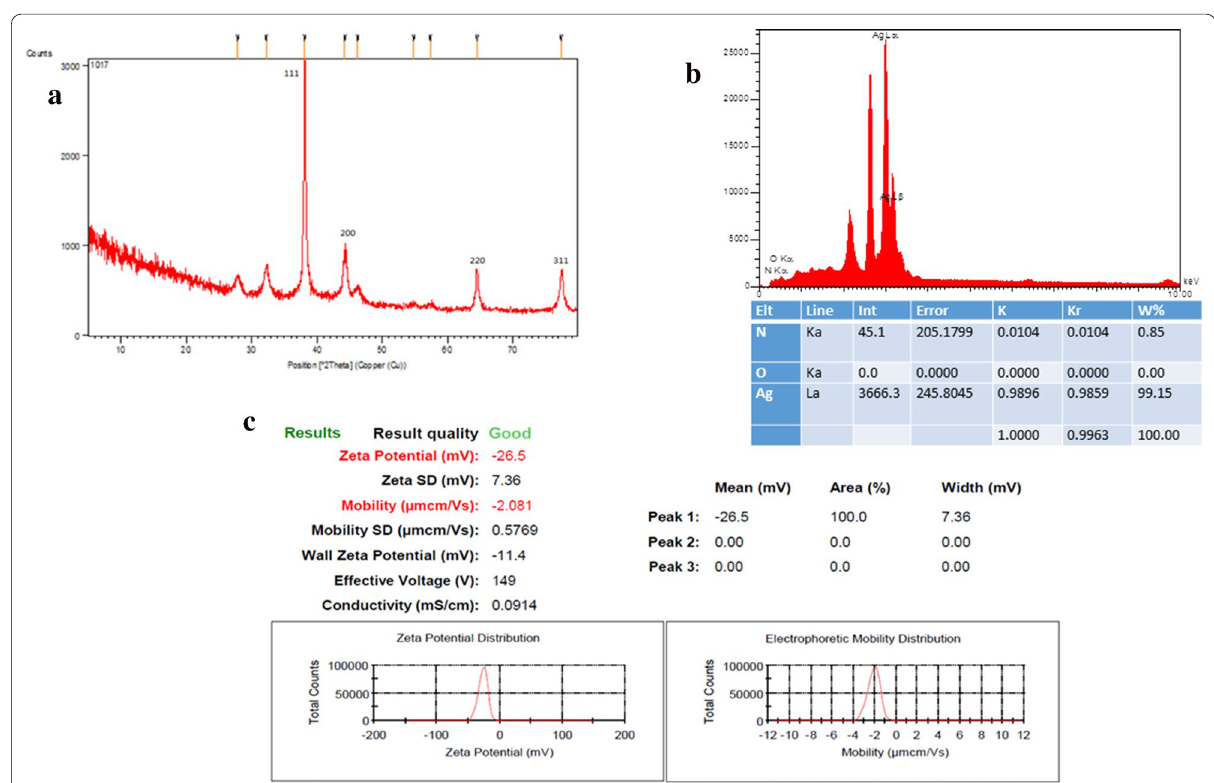
Fig. 3 a XRD pattern, b EDS spectrum, and c Zeta potential of AgNPs synthesized using Juniperus polycarpos